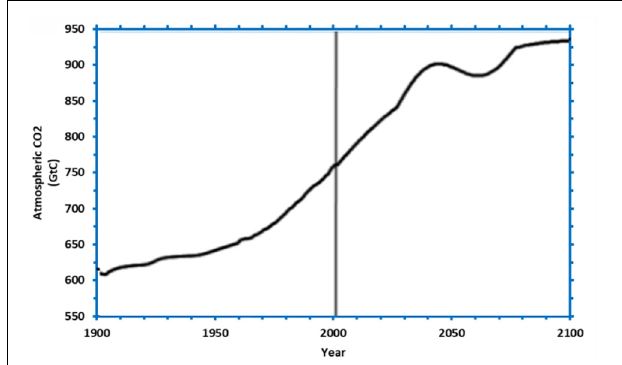
FIGURE 9 | The CO 2 concentration stabilization trajectory to be used as the difficult